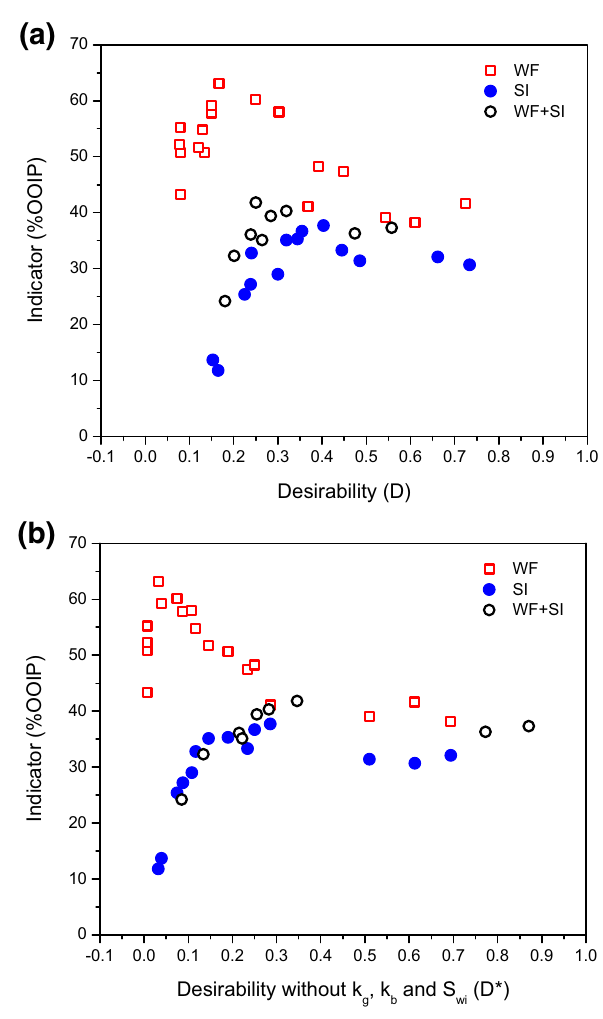
Fig. 8 Desirability combined from the affecting factors: a combined desirability ( D ) of all effecting factors ( I ′ w , W R , cos θ , kg , k b and S wi ) and b combined desirability ( D *) of all effecting factors without gas and brine permeabilities and initial water saturation ( k g , k b and S wi ) to the oil recovery (%OOIP) as an assessing indicator. The data are shown in three set of recovery methods including waterflooding (WF: hallow square), spontaneous imbibition (SI: solid circle) and waterflooding after spontaneous imbibition completed (WF + SI: hallow